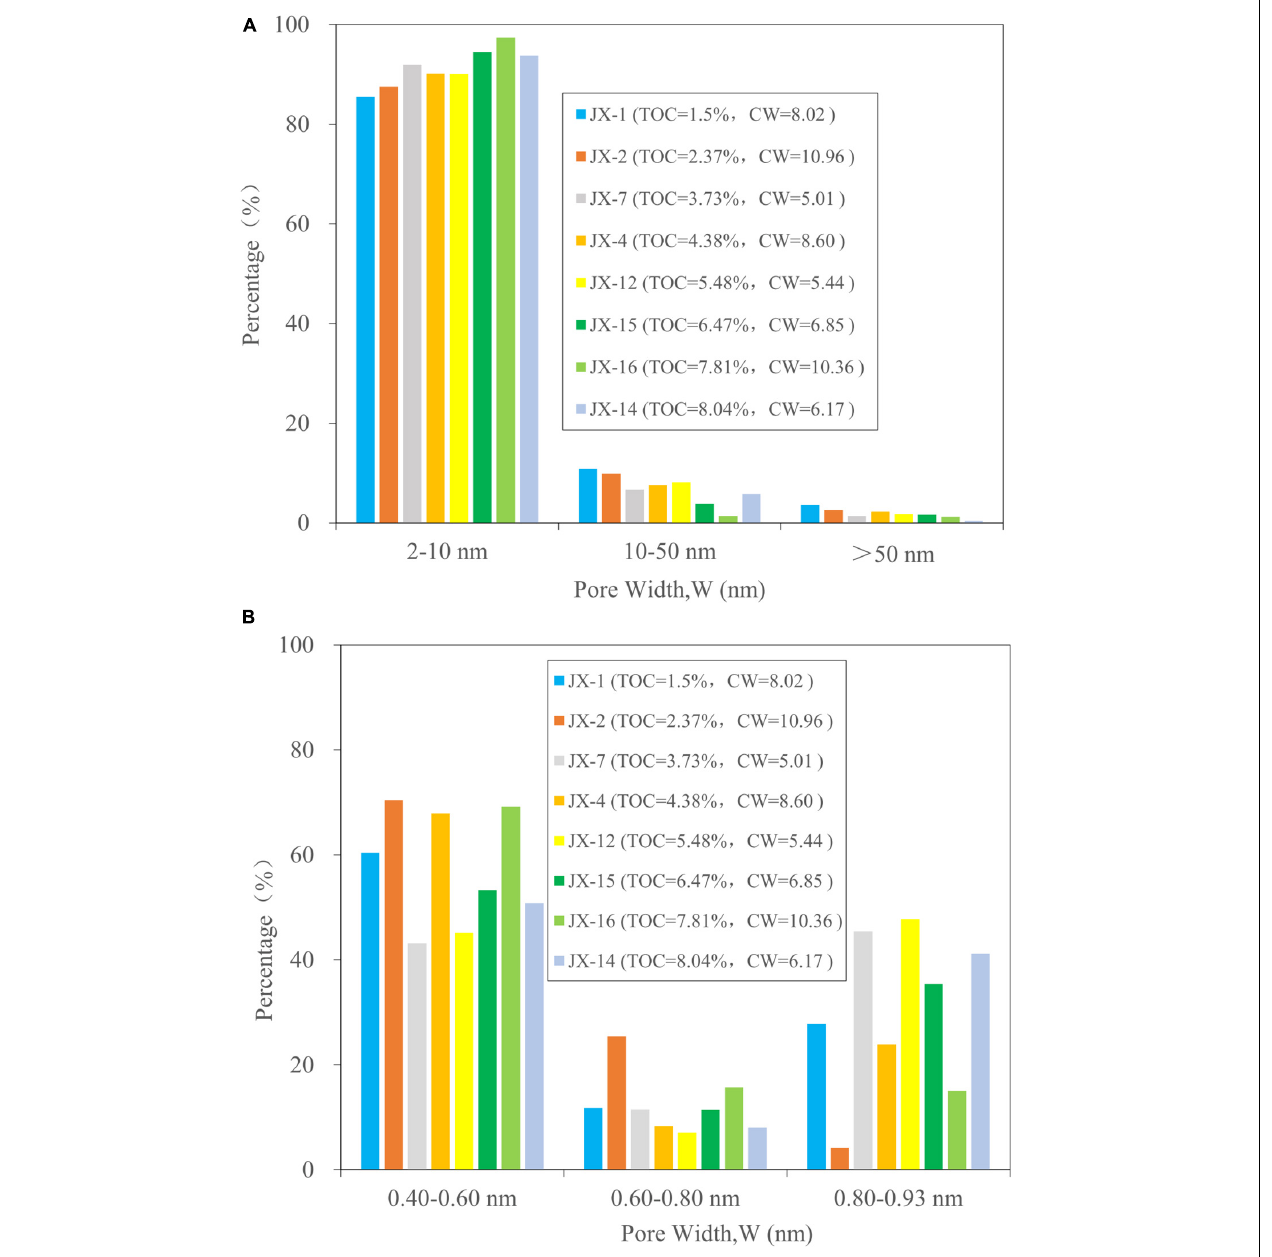
FIGURE 7 | Percentages occupied by irreducible water in the non-micropores (A) and micropores (B) for the selected 8 samples. It should be pointed out that pores smaller than 0.40 nm were not counted since the diameter of H 2 O molecules is approximately 0.40 nm, and the percentages occupied by water in the pores of 0.93–2.00 nm were not observed since the effective micropore range is only 0.36–0.93 nm in the present study.